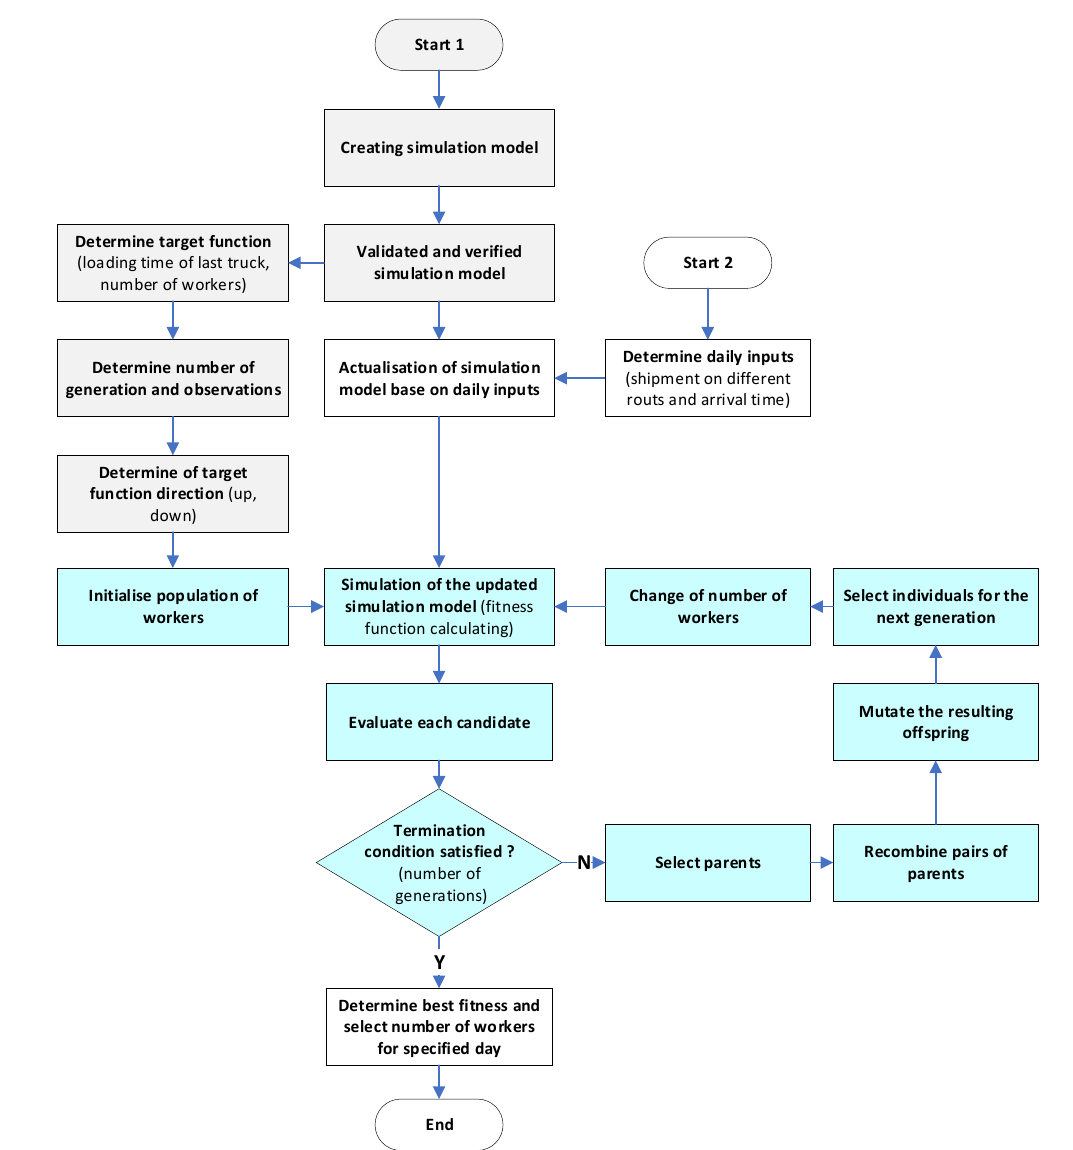
Figure 5. Genetic algorithms are used in a simulation to determine the number of workers in a sorting warehouse.